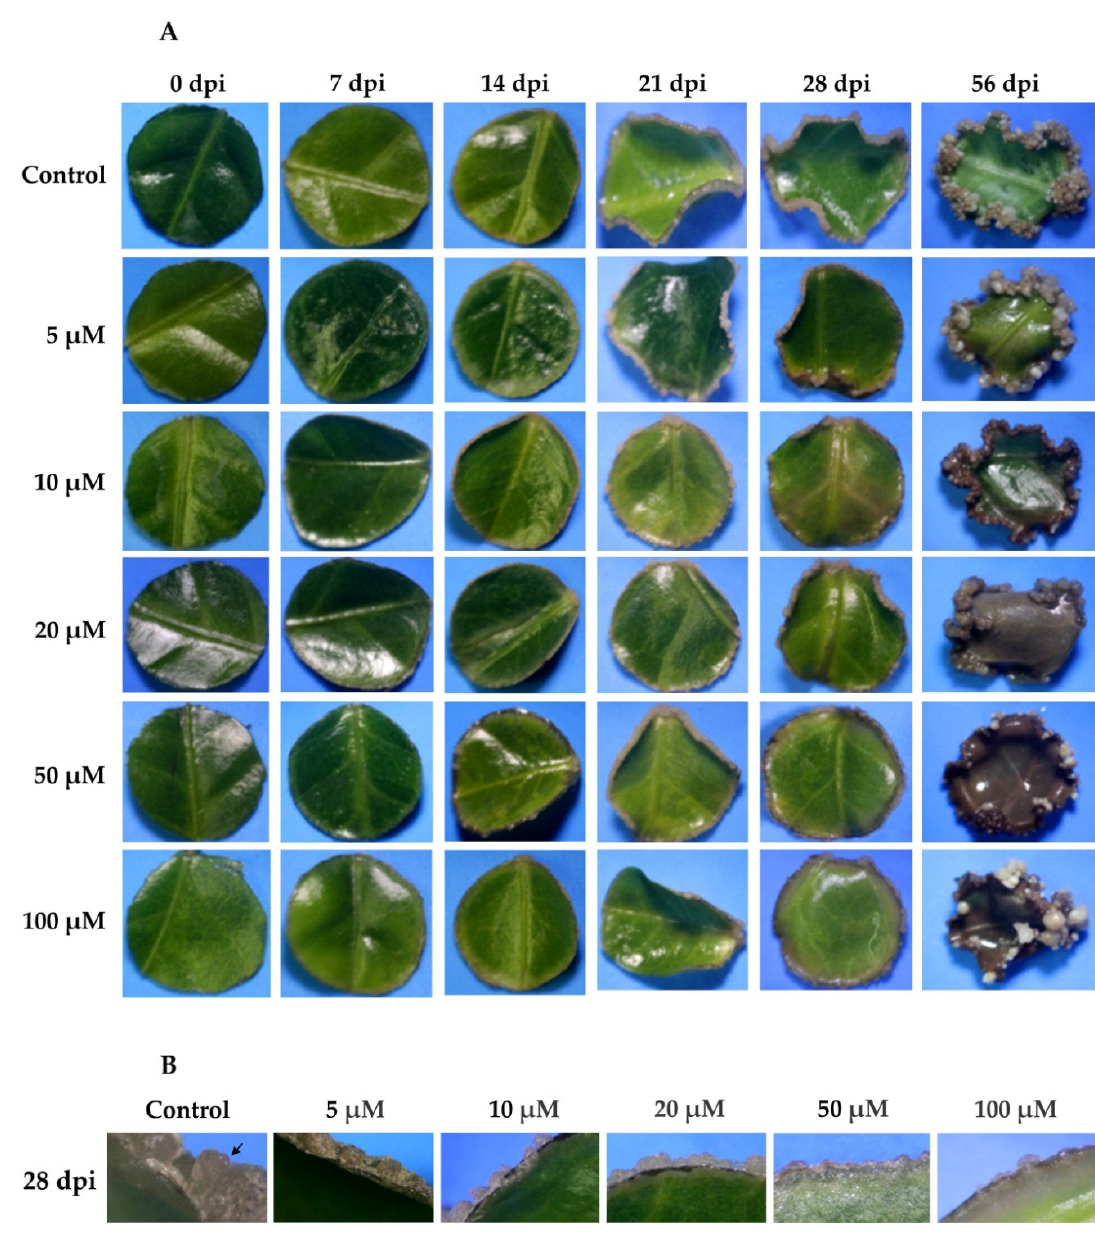
Figure 8. Effect of yucasin during the induction of SE in C. canephora . ( A ) , Different concentrations of yucasin were applied exogenously (5, 10, 20, 50, and 100 µM) to the pre-treatment medium. The effect of yucasin was documented every seven days until 28 dai, and then at 56 dai of SE. ( B ), A comparison of the effect of yucasin 28 dai for all the yucasin concentrations. Note the abundance of proembryogenic mass on the control, as well as the presence of proembryos (black arrow).